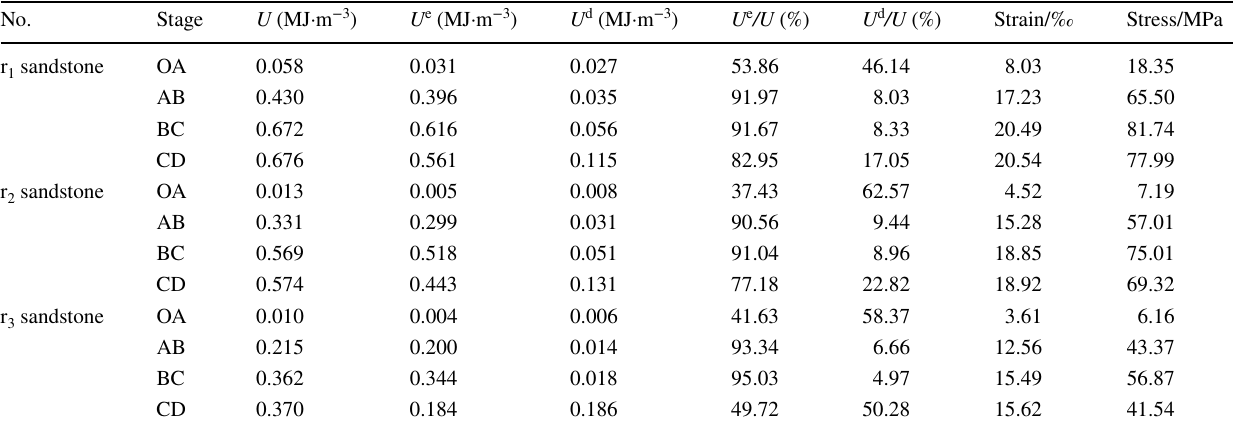
Table 3 Energy parameters of each sandstone samples at each stage